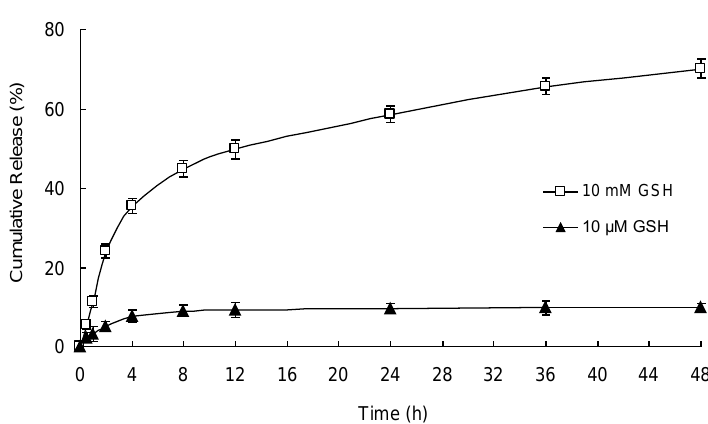
Figure 7. Release of PTX from PTX-loaded mPEG-CS(SH)-CHO micelles under different levels of glutathione